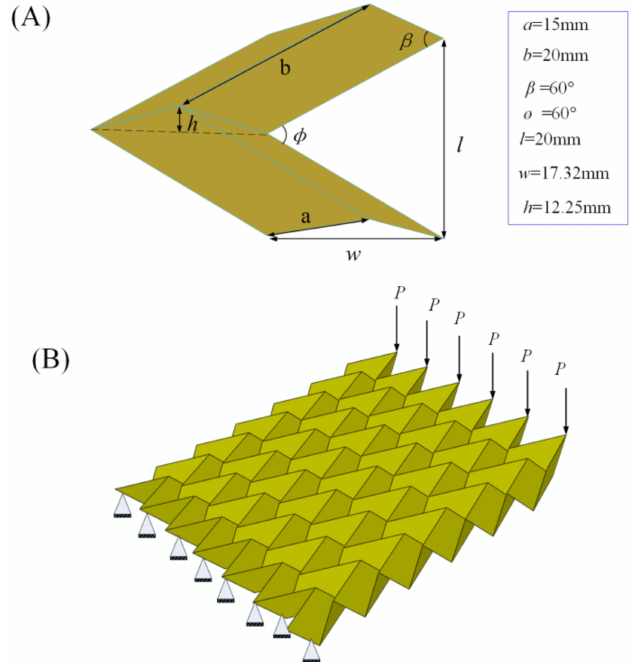
Figure 4. ( A ) The geometry for the unit cell of the Miura-ori; and ( B ) the geometry, boundaries, and loading conditions for the Miura-ori-based cantilever.